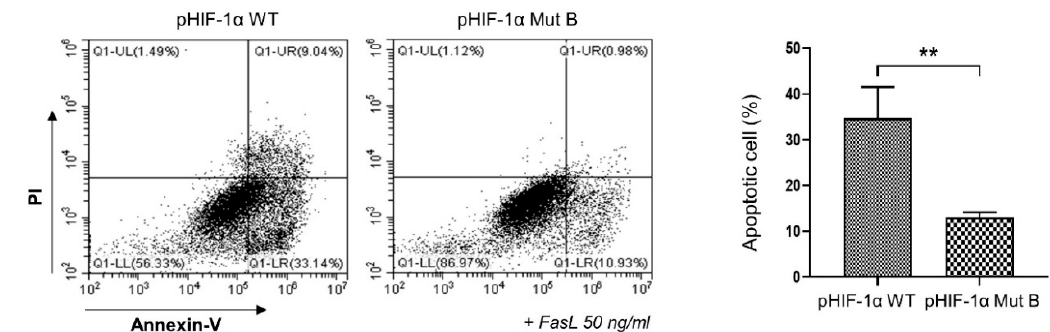
Figure 3. CA HIF-1 α (pHIF-1 α Mut B) reduces the apoptosis induced by FasL treatment. NP cells were transfected with pHIF-1 α WT or CA HIF-1 α , and NP cell apoptosis was induced by the treatment with 50 ng/mL of FasL. After 24 h, annexin V-positive cells were enumerated by flow cytometry. PI, propidium iodidin ** p -value < 0.01.